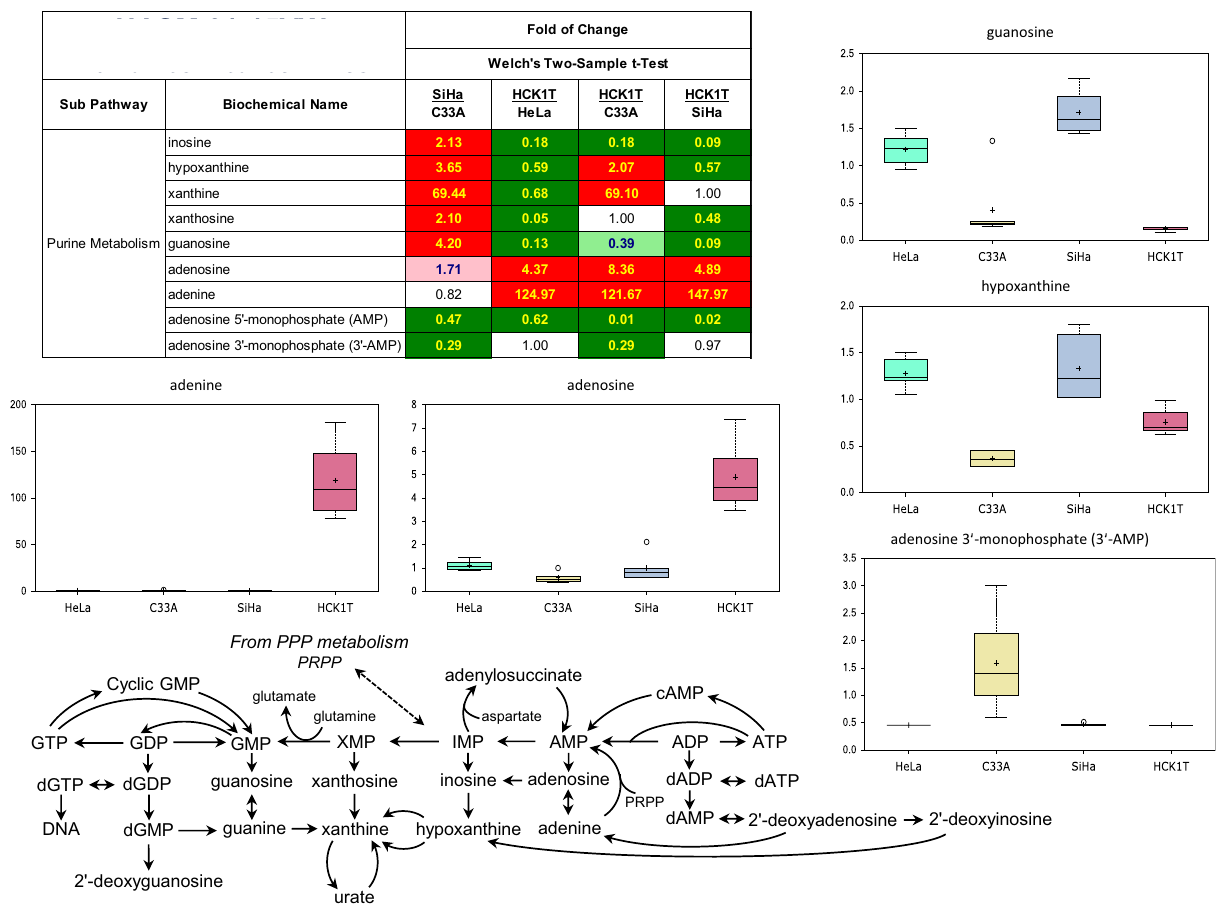
Figure 2. Metabolomic analysis of the differential nucleic acid metabolism of the four cervical cell lines. Selected biochemicals are displayed as box plots. Each box plot provides a measure of scaled intensity, normalised by protein content. The relevant pathway map and a heat map with the major biochemical changes is shown. For the color key of the heat map, see the legend of Fig.